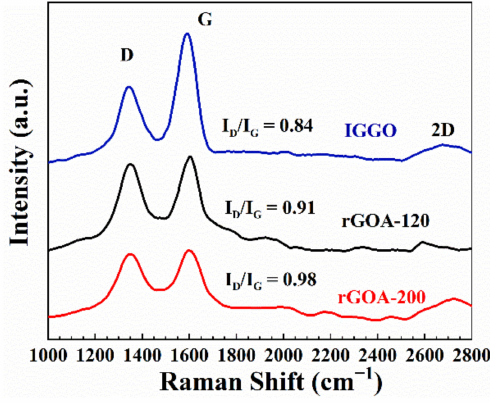
Figure 6. Raman spectra of IGGO, rGOA-120 and